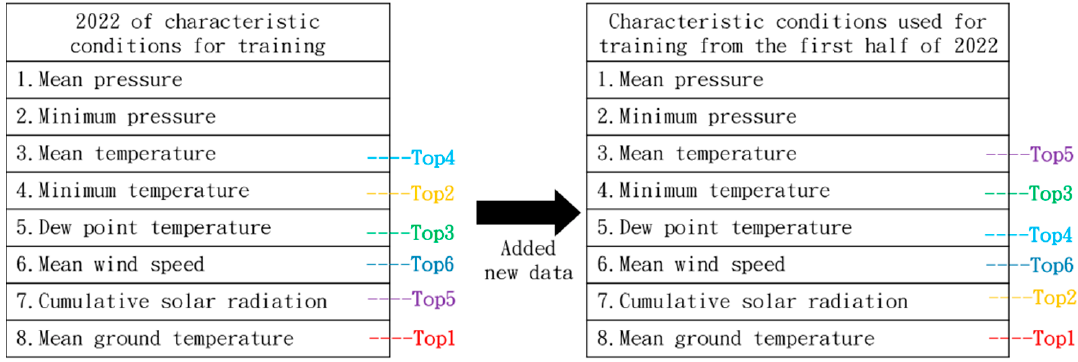
Figure 5. Transfer of historical data from 2020 to real-time data from 2021.